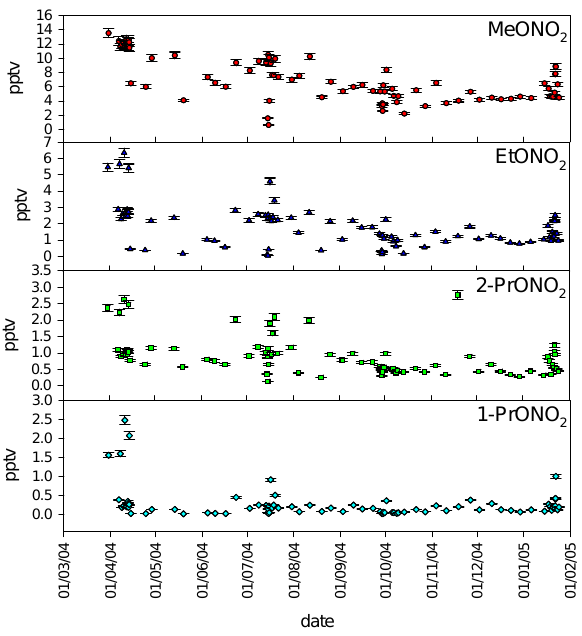
Fig. 1. Measurements of methyl, ethyl, 2-propyl and 1-propyl ni- trate from whole air samples. The error bars show the 4.6% mean precision derived from all the alkyl nitrate measurements during the campaign. Note the data are plotted on different scales.